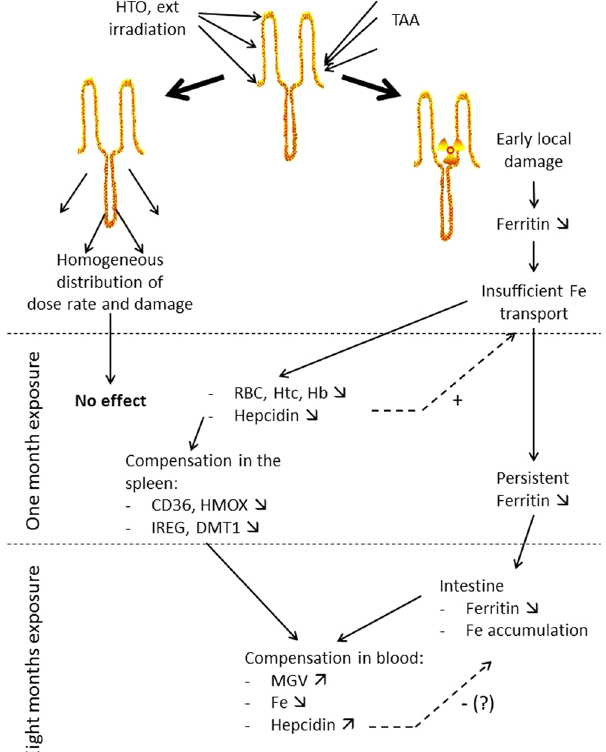
Figure 11. Schematic view of the results obtained after one or eight months of exposure to TAA, HTO and external irradiation and of the hypothesis possibly explaining the observed results. The hypothesis proposed is that local damages produced by TAA in the intestine induced a decreased ferritin expression which resulted in a decreased ability of iron transport through the intestinal barrier. As a result of insufficient iron availability, a decrease in RBC is observed and changes in iron metabolism in the spleen after one month of exposure. Due to both the persistent damage in the intestine with iron accumulation, this leads to iron deficit in the blood at 8 months. The increase in MVG thus appears as a compensation mechanism for the reduced number of RBC at one month. Hepcidin low concentration in the blood appears as a positive regulator of iron capture by the intestine at one month, not effective due to the persistent damage with the continuous presence of TAA. Such local damage is not induced by HTO or external irradiation due to the homogeneous distribution of radiation dose and